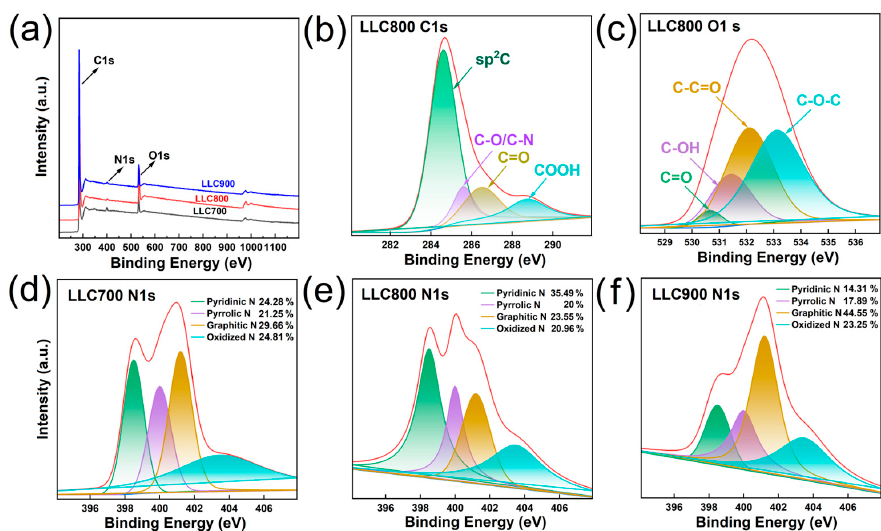
Figure 4. XPS spectra of LLCs at different pyrolysis temperatures ( a ); C1s ( b ) and O1s ( c ) XPS spectra of LLC800; N1s XPS spectra of LLC700 ( d ); N1s XPS spectra of LLC800 ( e ); N1s XPS spectra of LLC900 ( f ).